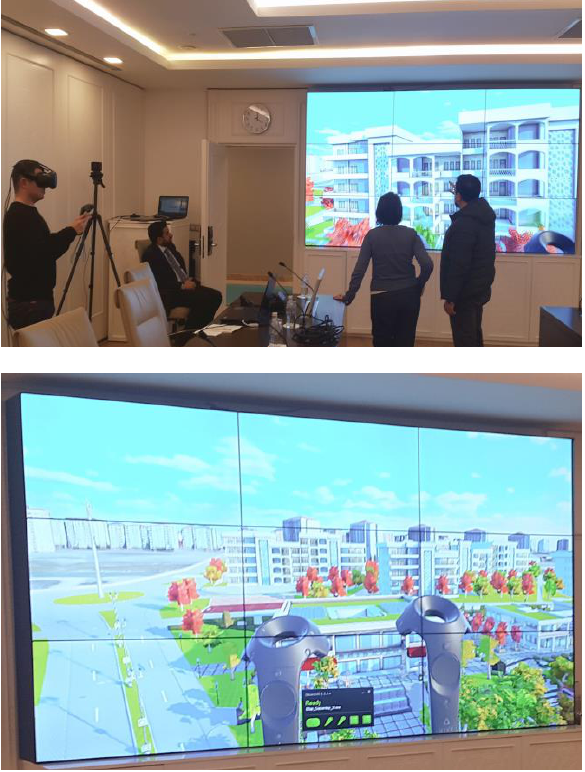
Figure 6. VR experience for exploring Bizimsehir with HTC Vive VR